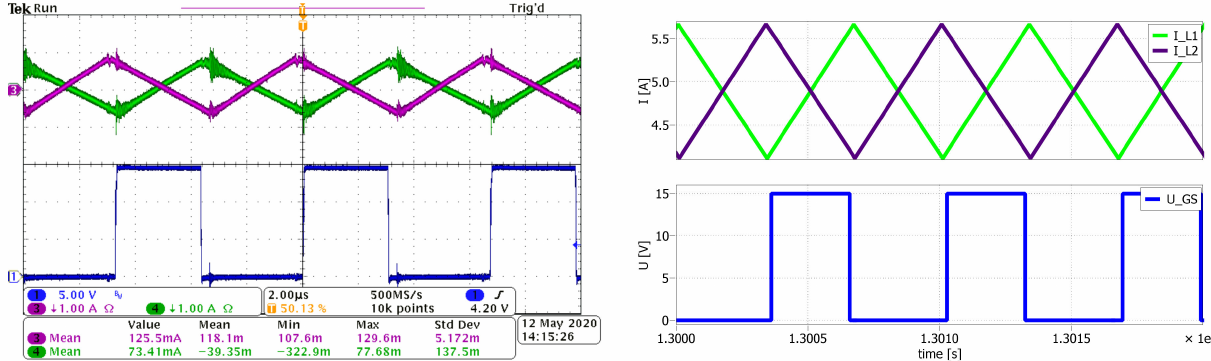
Figure 12. Time waveforms of inductor currents (violet and green) and gate drive impulse (blue) of the non-modular Bi-BB converter for the experimental measurement sample ( left ) and simulation ( right ), in boost